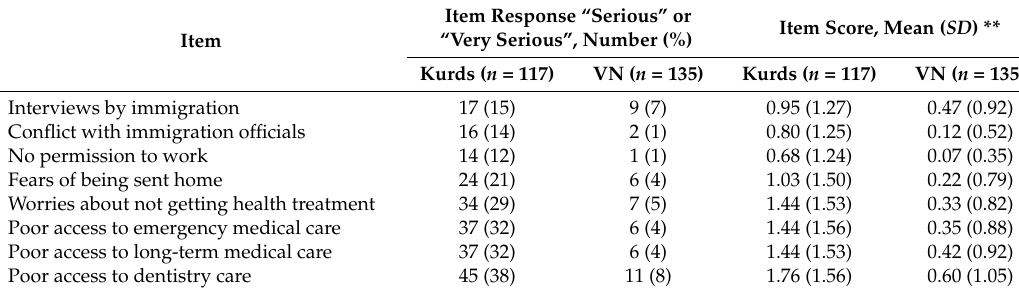
Table 1. Post-Migration Stress by Item and by